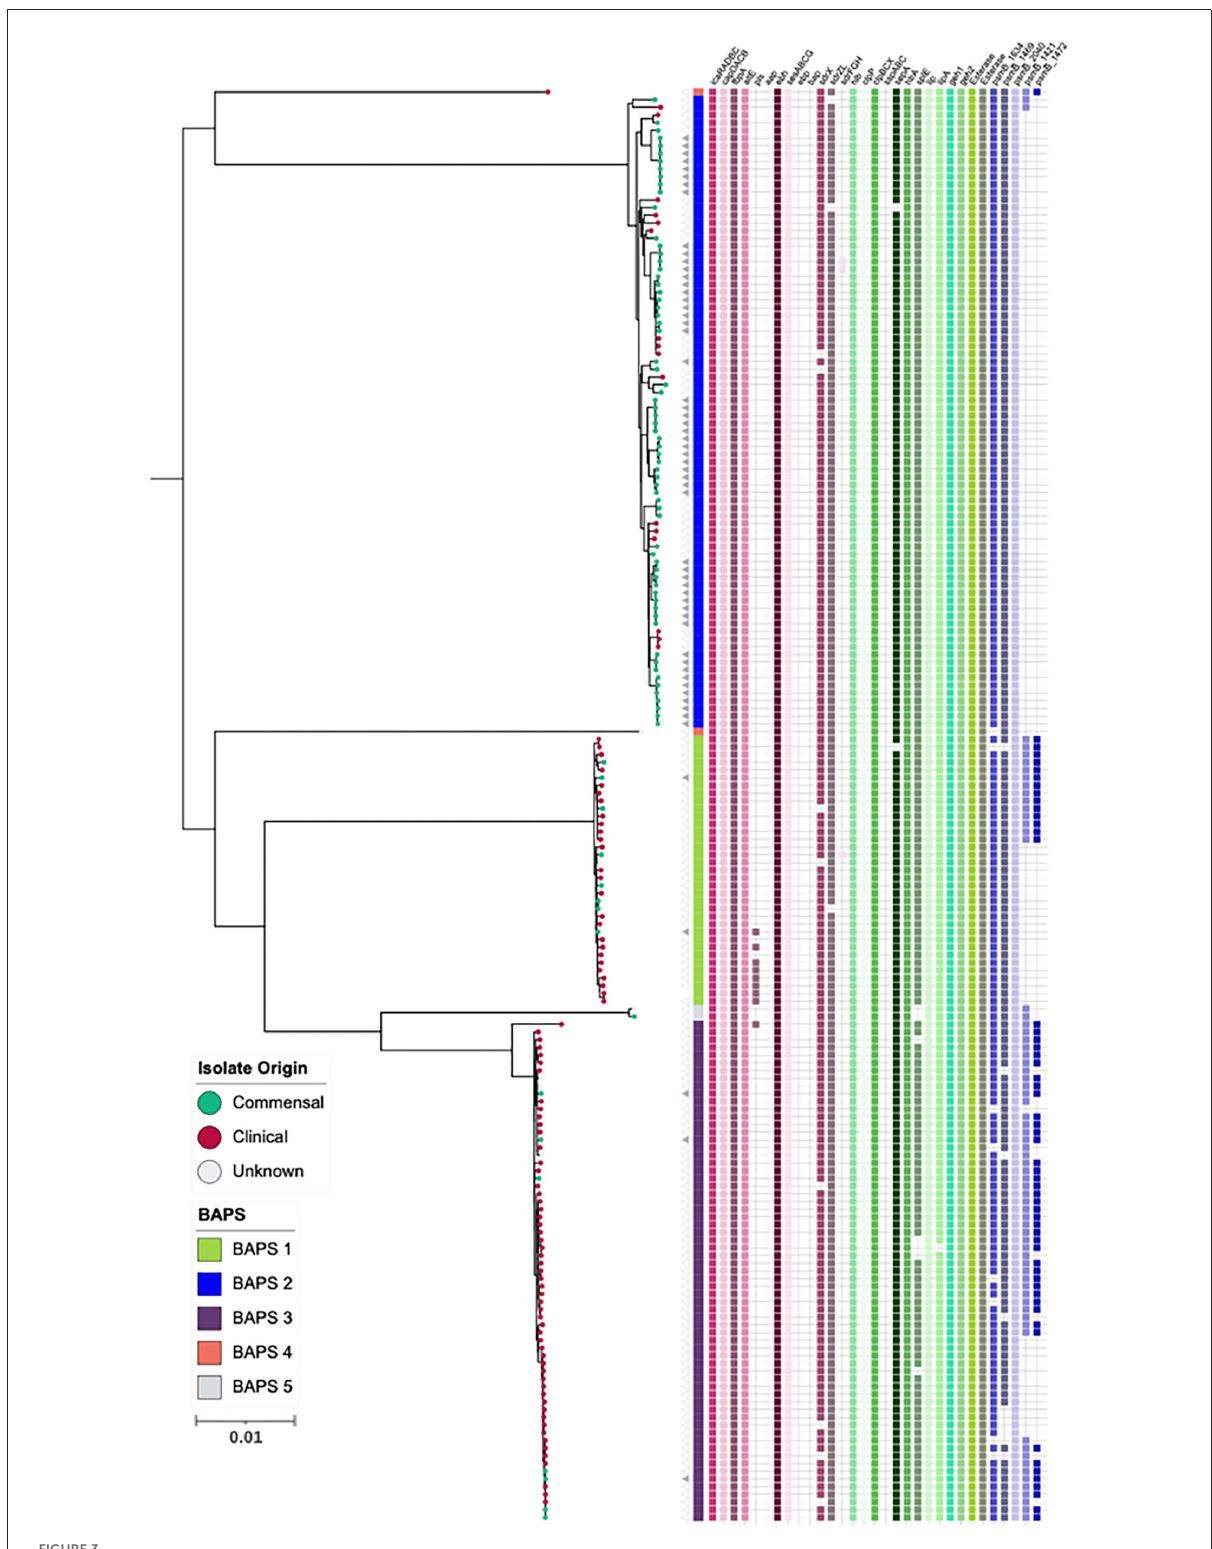
FIGURE3 Maximum-likelihood phylogeny based on core genome alignments of 186 S. capitis isolates, presenting the presence and absence of genes linked to CoNS virulence potential. ML tree is midpoint rooted, and bootstrap support values were calculated from 1,000 replicates. The